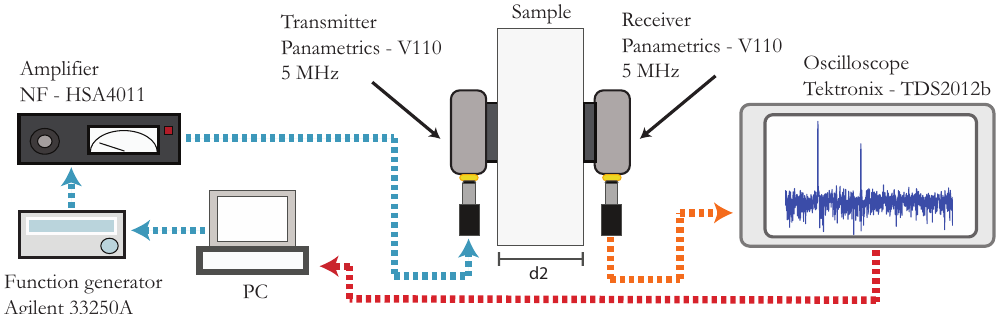
Figure 3. Schematic illustration of the experimental setup used for SHG. A sinusoidal voltage waveform is amplified and used to generate an ultrasonic signal, emited by one of the transducers. The second one receives the transmitted signal and its FFT spectrum is computed by an oscilloscope. Both the fundamental and first harmonic amplitudes are recorded on a personal desktop